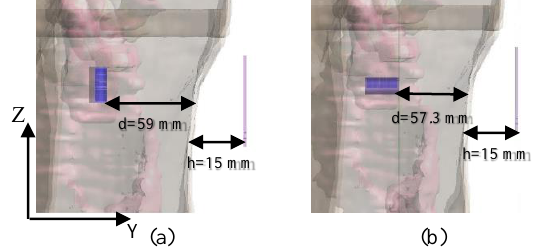
Figure 8. Link investigation scenarios between the ingestible and the on-body antenna in the anatomical model. (a) Vertical polarization, (b) Horizontal